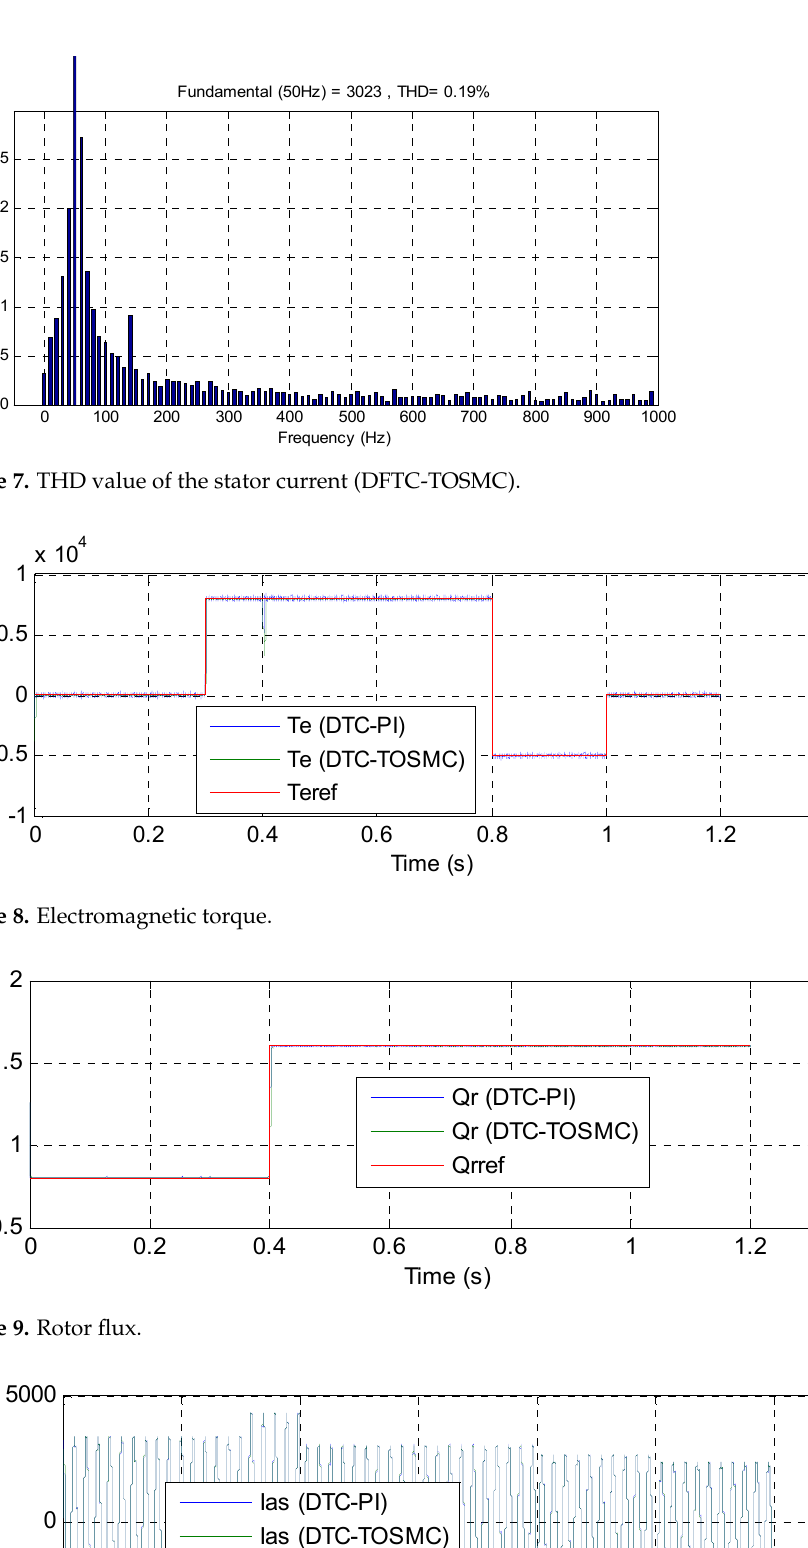
Figure 6. THD value of the stator current (DFTC-PI).